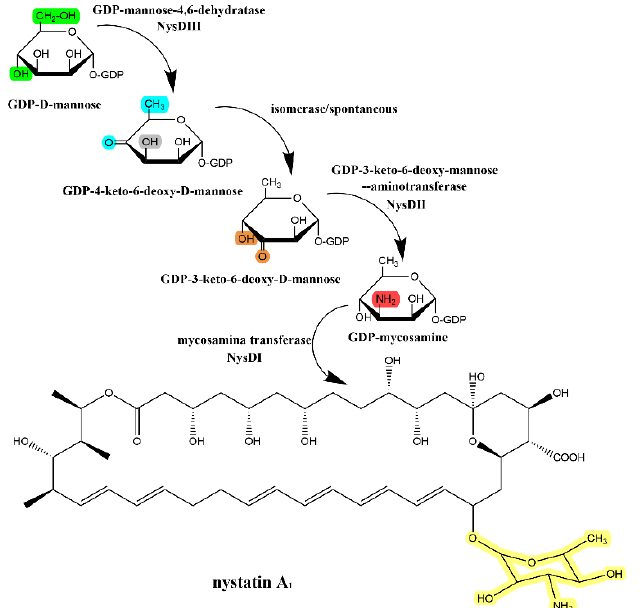
Figure 5. Addition of mycosamine in the biosynthesis of nystatin. The highlights show the differ- ences before and after each catalytic step. before and after each catalytic